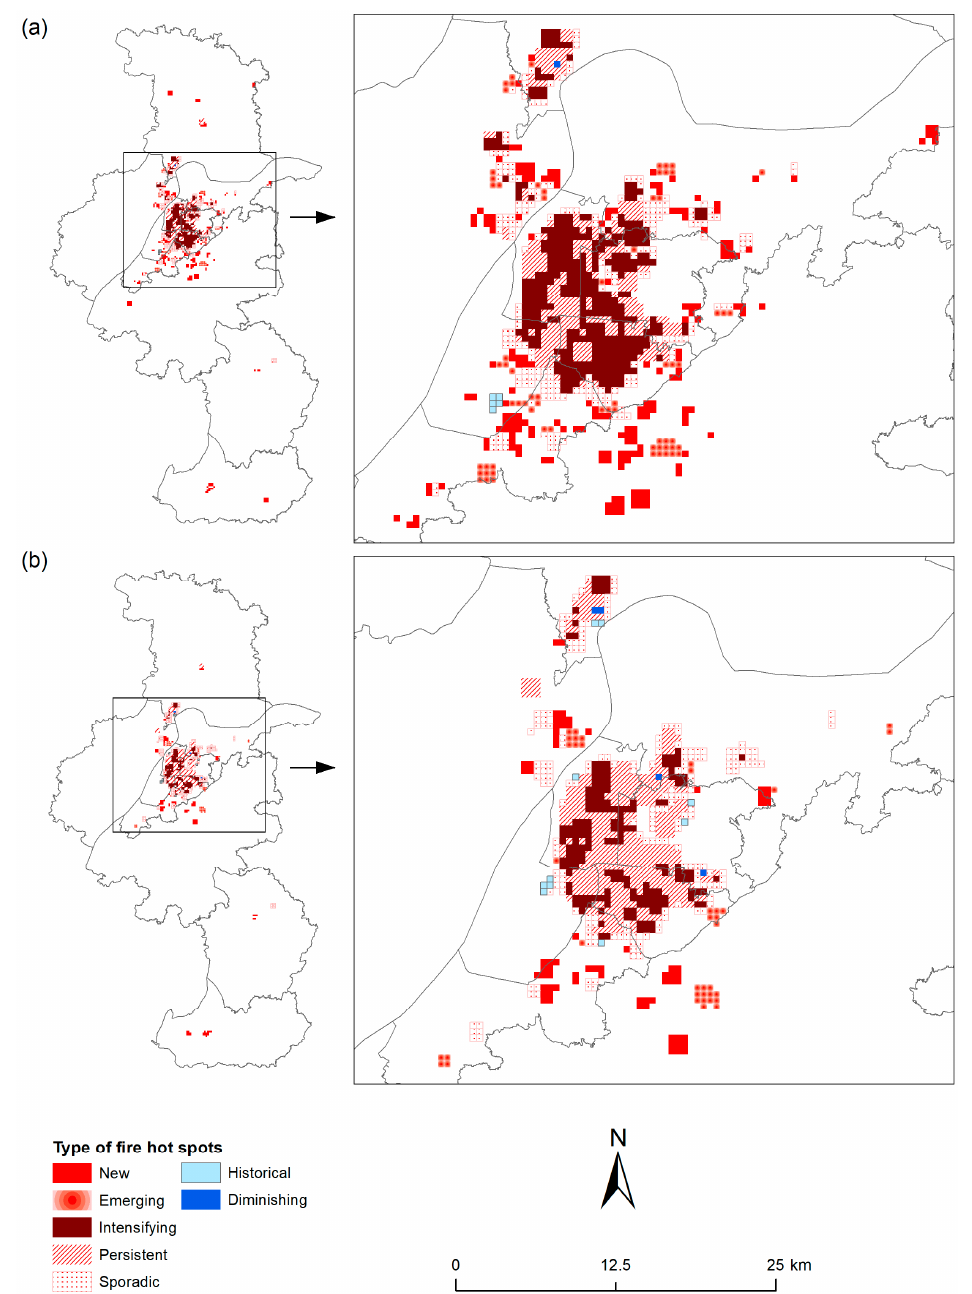
Figure 7. Hot spots of urban fires: ( a ) total fire and ( b ) dwelling fire.